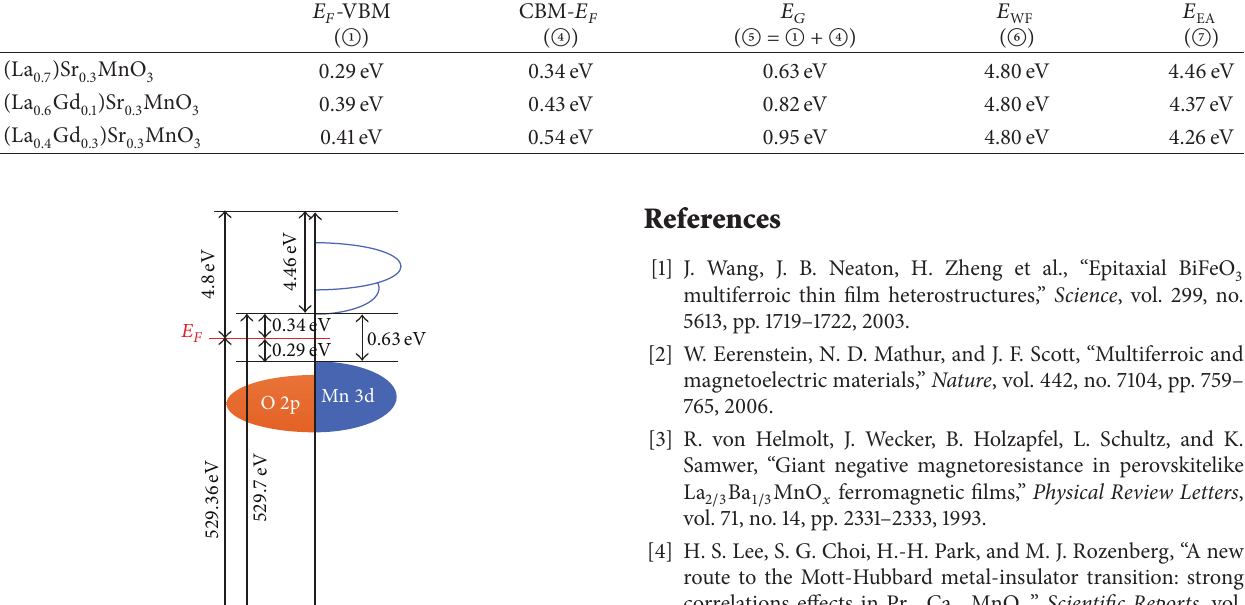
Table 1: Measured values for combining band structure of (La